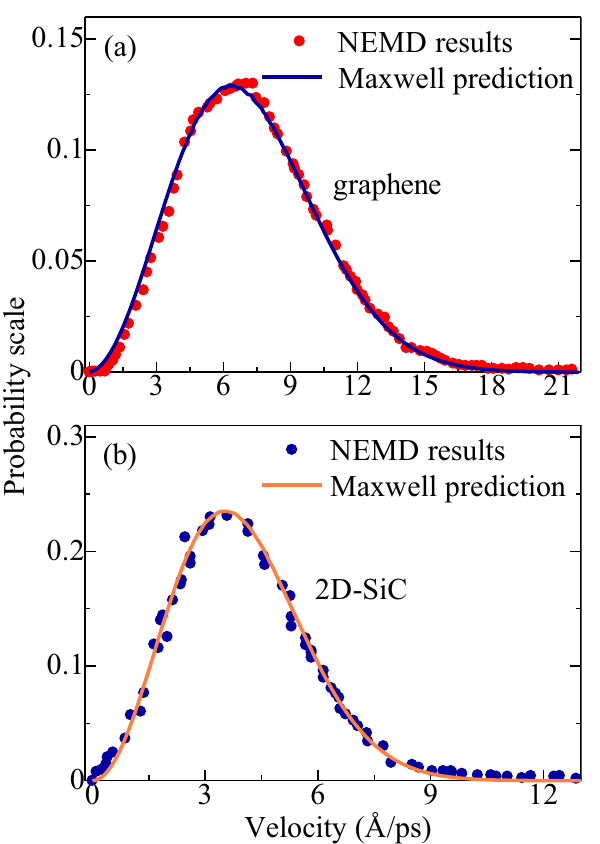
Figure 2. Comparison of the atomic velocity distribution of ( a ) graphene and ( b ) 2D-SiC layers with Maxwell prediction at steady-state.